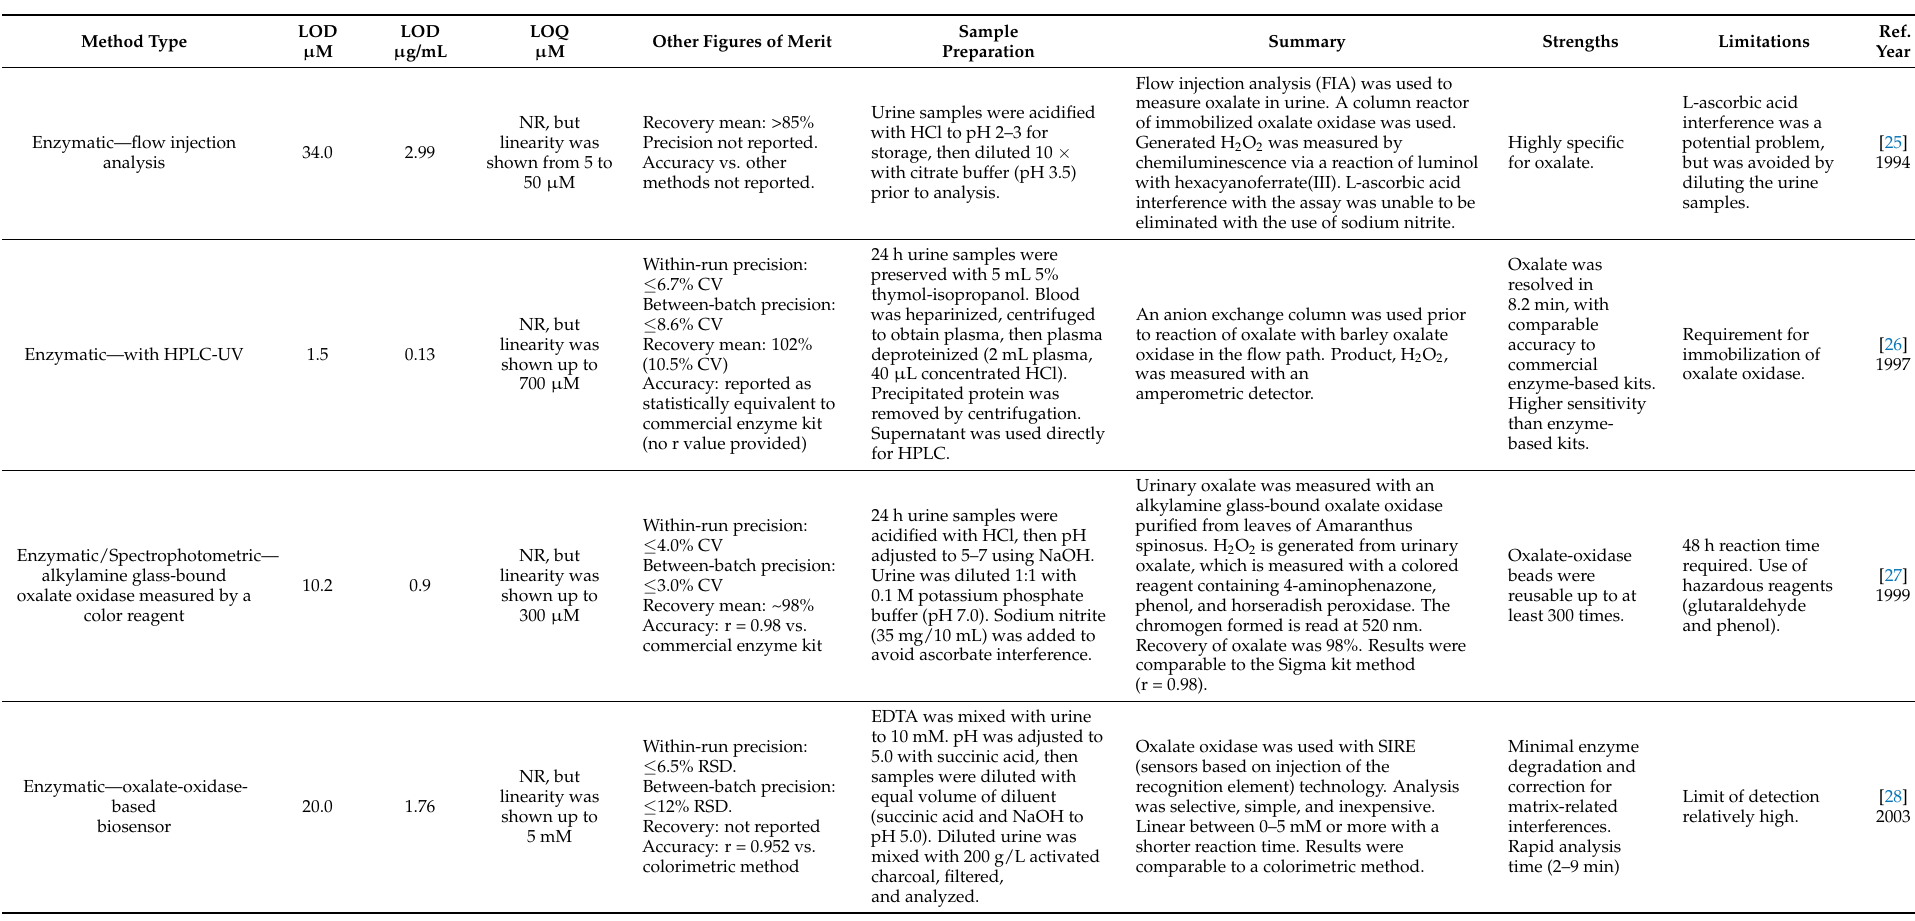
Table 1. Methods used for detection and quantification of oxalate. LOD, limit of detection; LOQ, limit of quantification; NR, not reported; RSD, relative standard deviation; CV, coefficient of